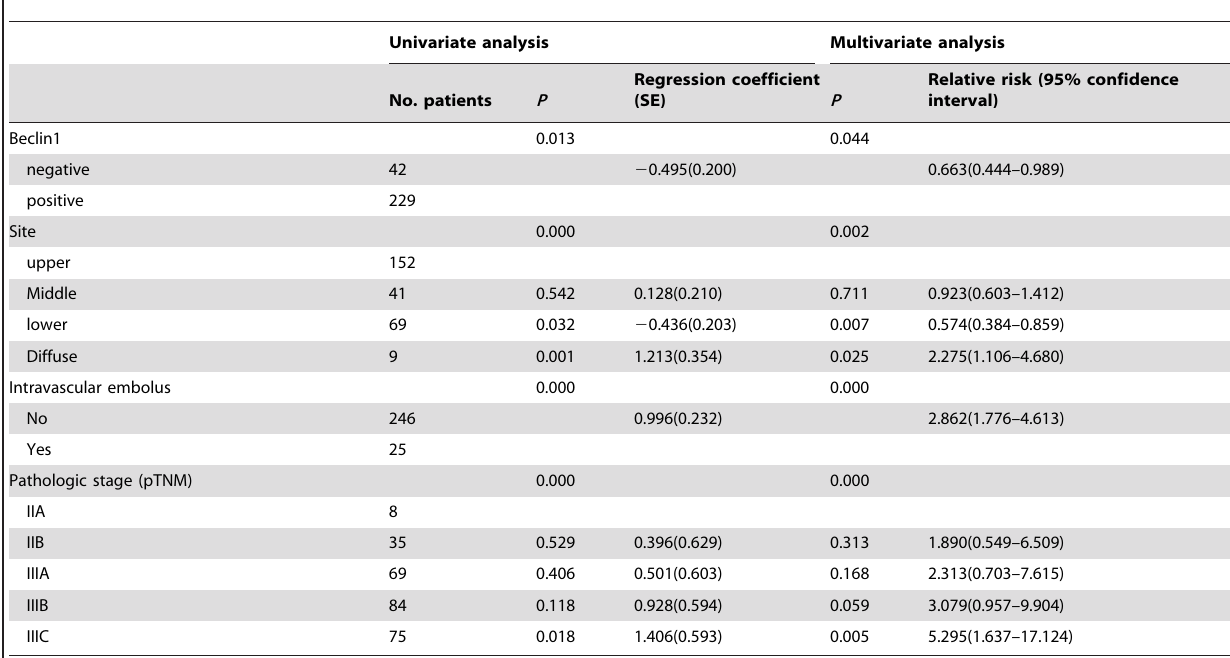
Table 2. Univariate and multivariate analysis of different prognostic variables in patients with gastric cancer by cox regression